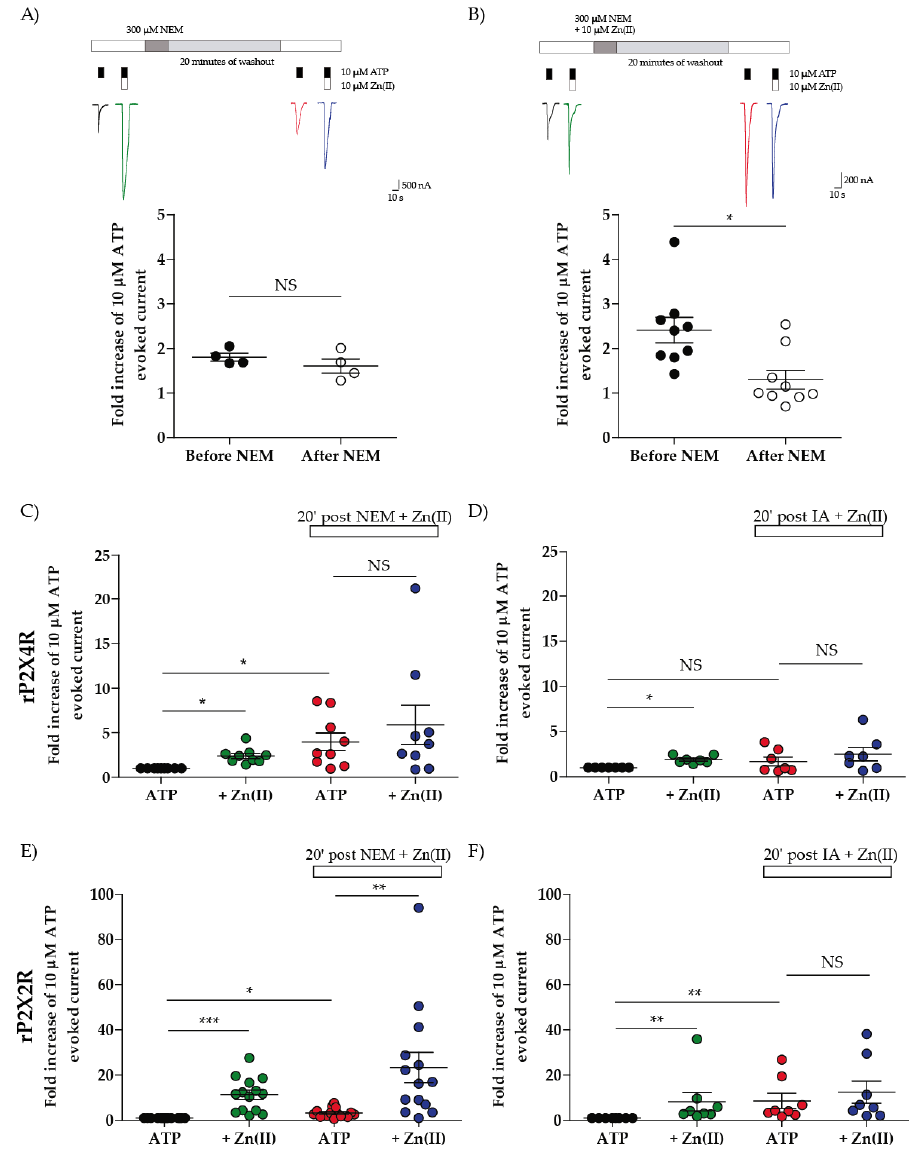
Figure 2. Zn(II) potentiation is annulled in rP2 × 4R by NEM + Zn(II) and IA + Zn(II) treatments but only with IA + Zn(II) treatment in rP2 × 2R. ( A ) representative traces (up) of ATP-evoked currents in absence (black) and presence of Zn(II) (Green) and after NEM treatment (red and blue) and quantification of the fold increase of ATP-evoked currents by Zn(II) (down). ( B ) representative traces (up) of ATP-evoked currents in absence (black) and presence of Zn(II) (Green) and after NEM + Zn(II) treatment (red and blue) and quantification of the fold increase of ATP-evoked currents by Zn(II) (down). * p < 0.05, NS = non significative according to the Mann–Whitney test. ( C , D ) quantification of the fold increase of first ATP evoked current in NEM + Zn(II) and IA + Zn(II) treatments in rP2 × 4R and ( E , F ) quantification of the fold increase of first ATP evoked current in NEM + Zn(II) and IA + Zn(II) treatments in rP2 × 2R. * p < 0.05, ** p < 0.01, *** p < 0.001 and NS = non significative according to the Kruskal–Wallis test.